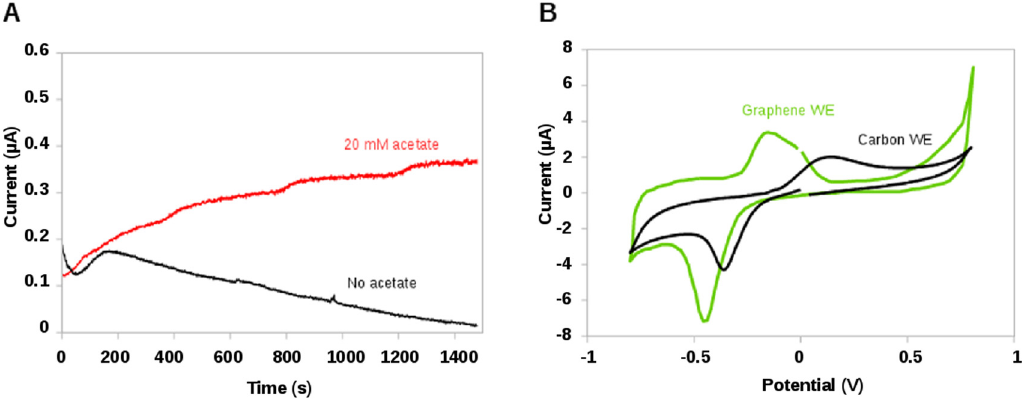
Figure 3. ( A ) Current production (at 0.2 V vs. Ag/AgCl) by G. sulfurreducens under acetate-excess conditions ( red ), and under acetate-limiting conditions just using intracellular acetate content ( black ); ( B ) CV of G. sulfurreducens on a graphene SPE ( green ) and a carbon SPE ( black ).